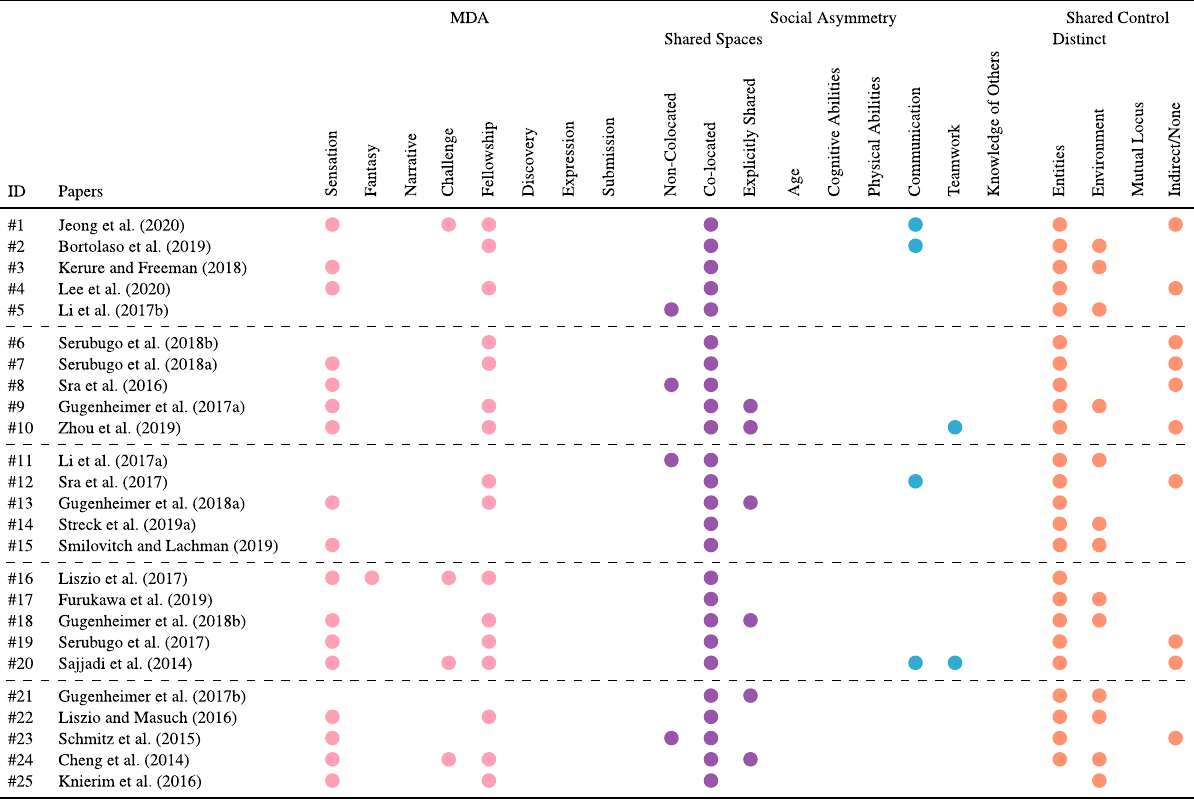
TABLE5| Anoverviewofhowthe fi nalcorpusofsurveyedpapers fi tsintothe(MDA,socialasymmetryandsharedcontrolpartsofthe) posthoc framework.Emptiercolumns indicate existing research gaps in the fi eld. Codings are subjective and relate to the paper as a whole (i.e., covering multiple applications).